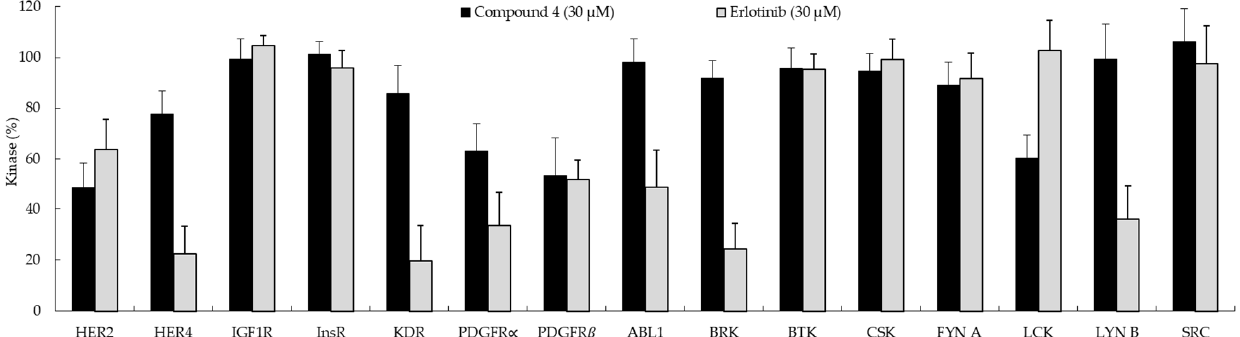
Figure 2. The inhibition of TKs by compound 4 and erlotinib at 30 µM concentration. All descriptive data were expressed as the Mean ± SD. All experiments were repeated three times.